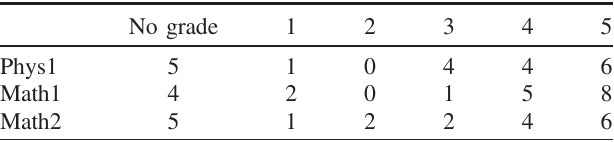
TABLE I. Frequencies of course grades from Phys1, Math1, and Math2. Courses are graded in a discrete scale from 1 (lowest) to 5 (highest). No grade means the number of students, whose study records did not indicate passing the